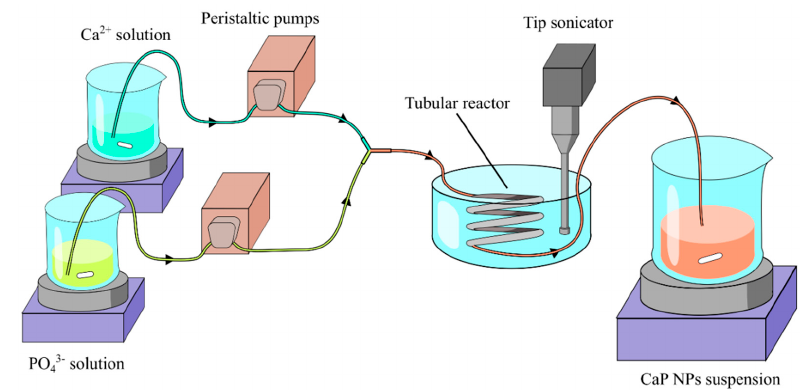
Figure 1. Schematic representation of the experimental apparatus.